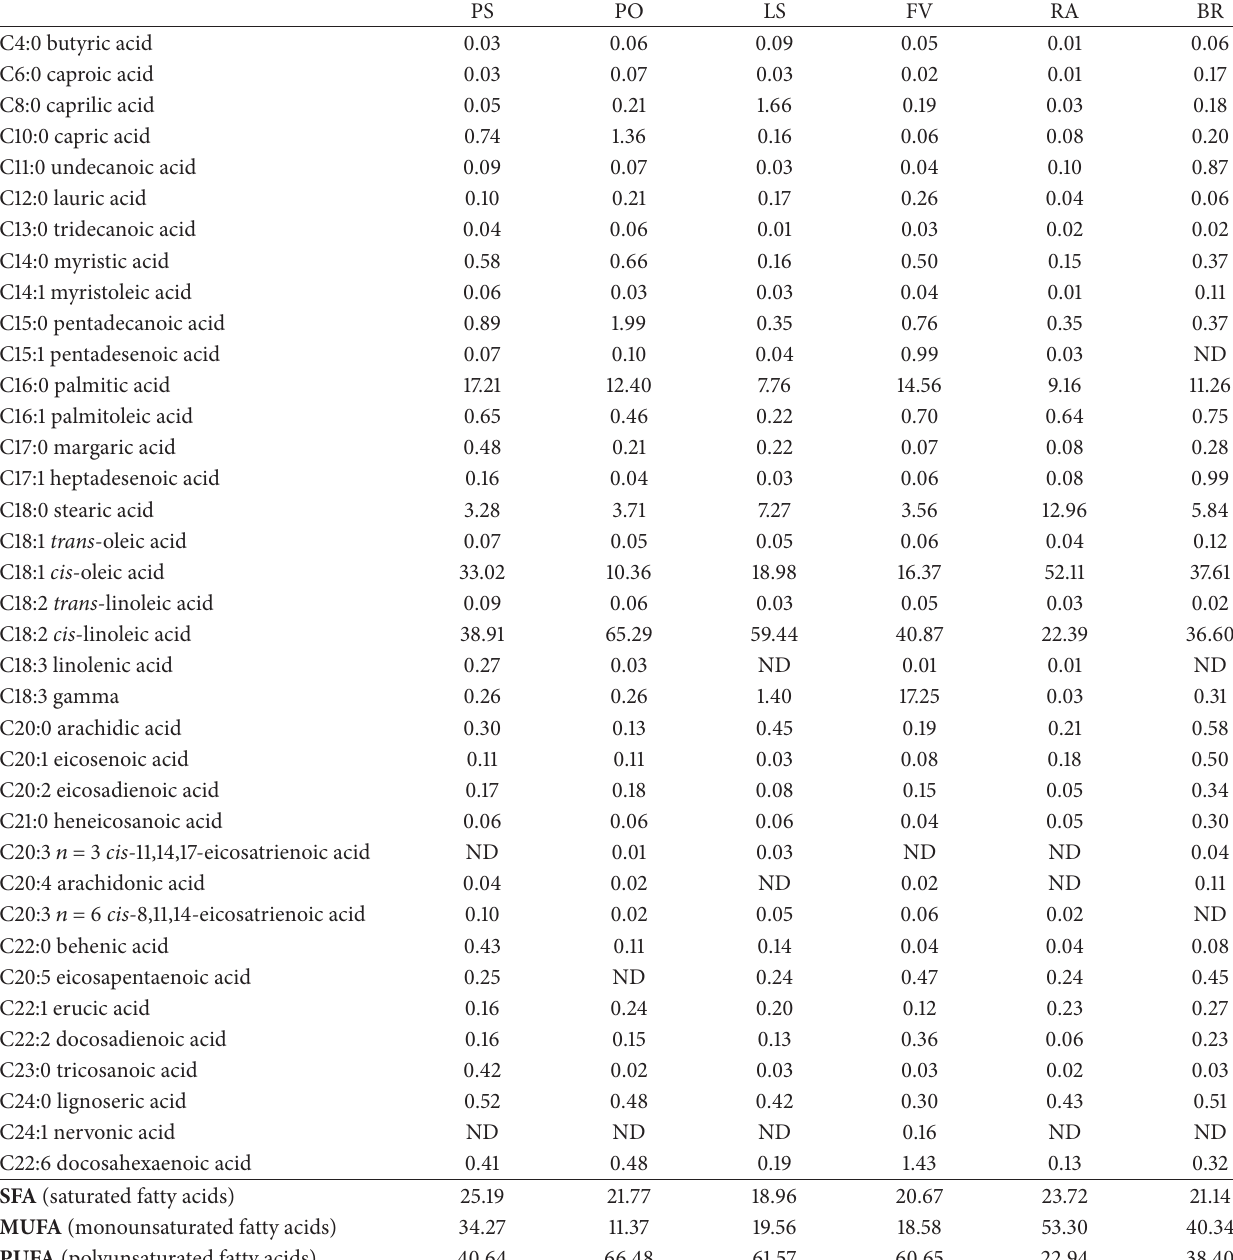
Table 2: Composition of fatty acids in six wild mushrooms (dry basis, % of total fatty